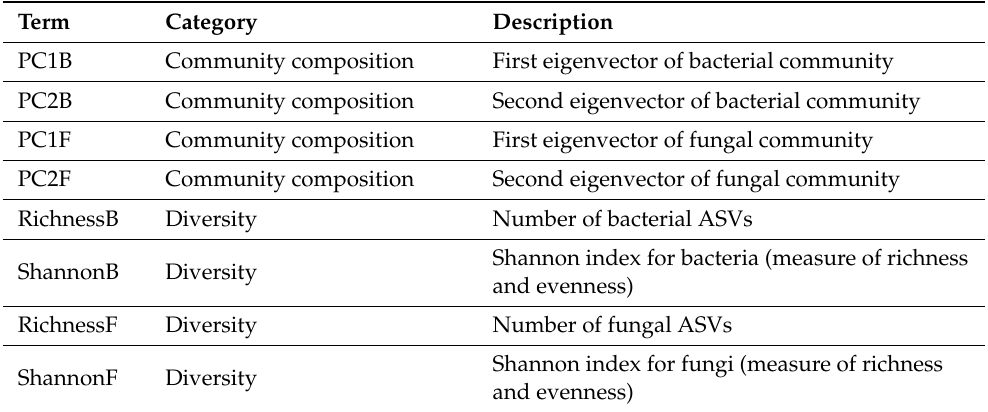
Table 1. Microbial parameters included in stepwise